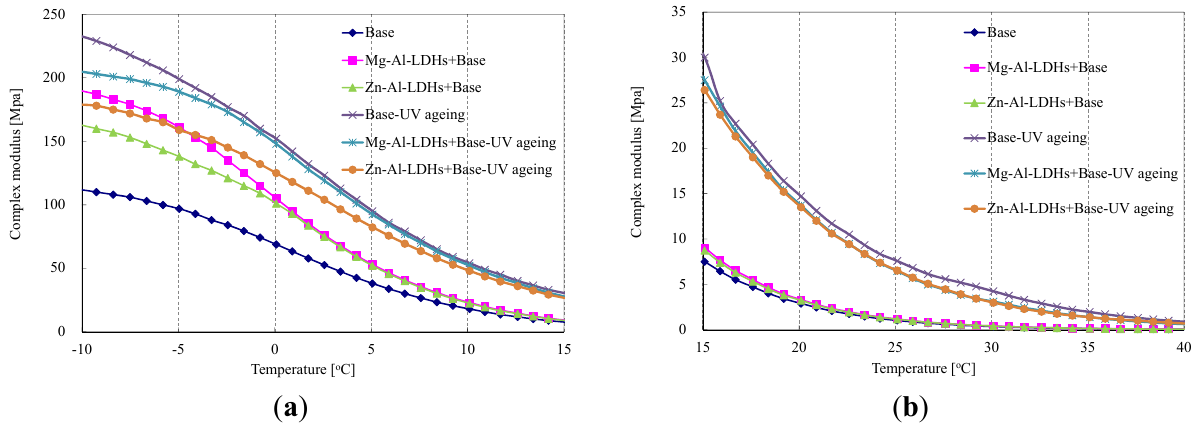
Figure 3. Effect of different LDHs on G * of SK-90 bitumen before and after UV aging.